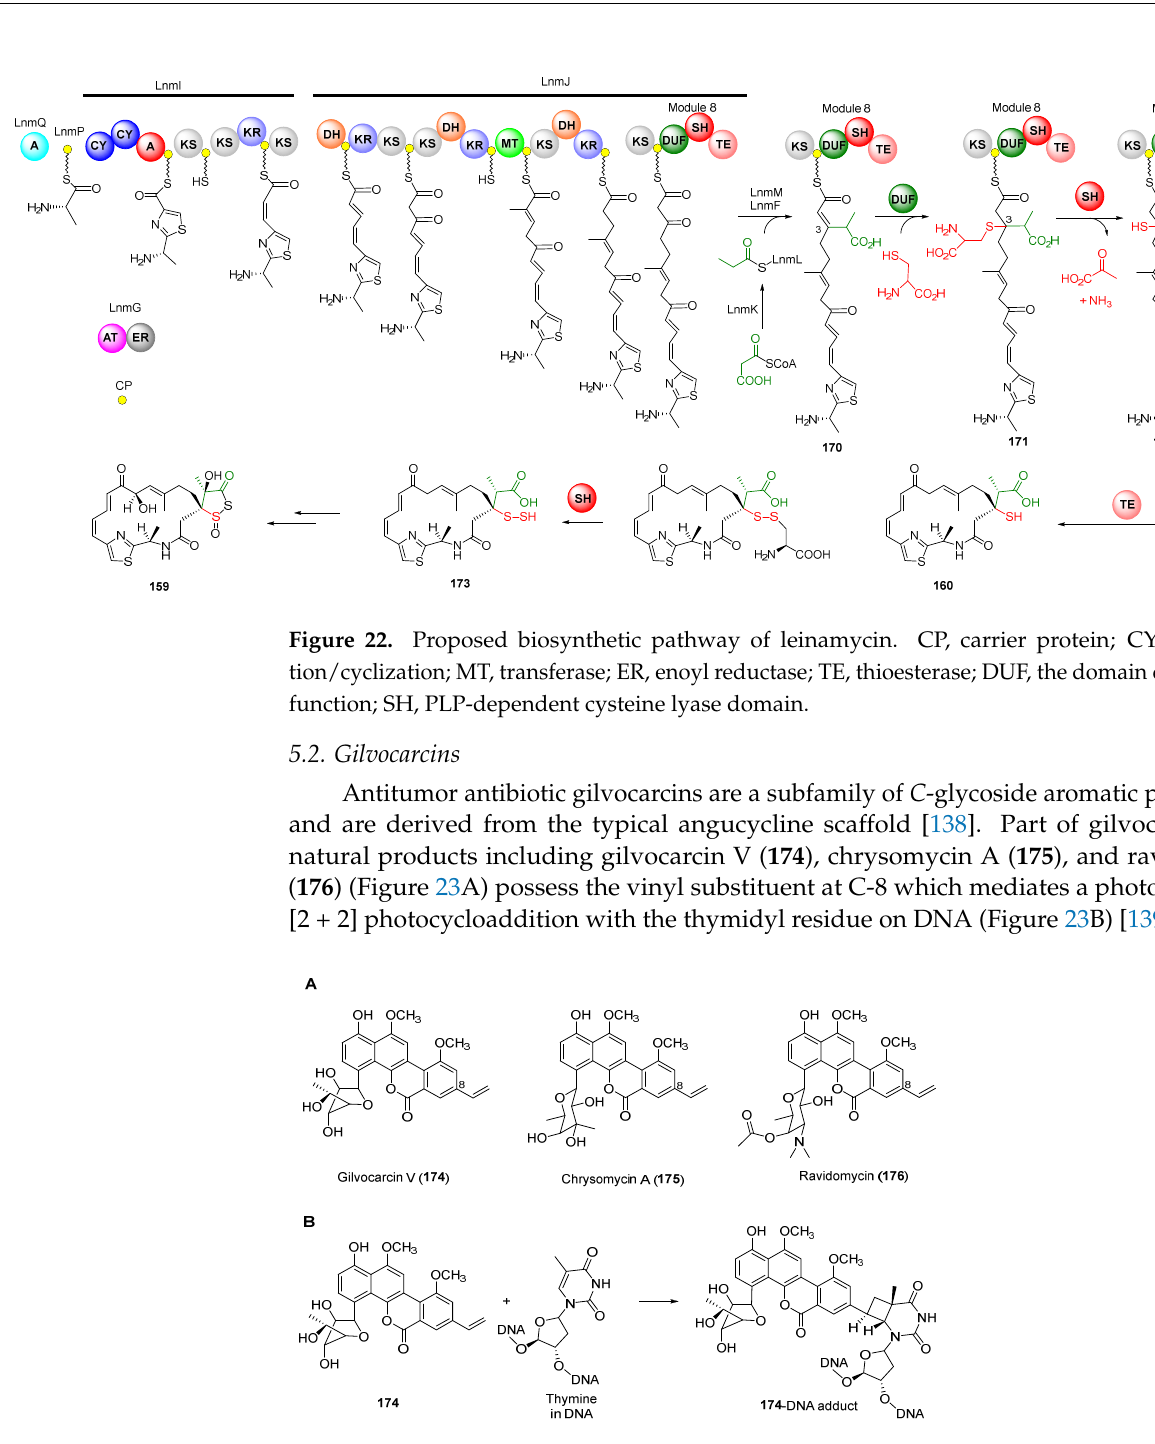
Figure 23. ( A ) Chemical structure of gilvocarcin V, chrysomycin A, and ravidomycin. ( B ) Mode of action of vinyl-containing gilvocarcin-type natural products.